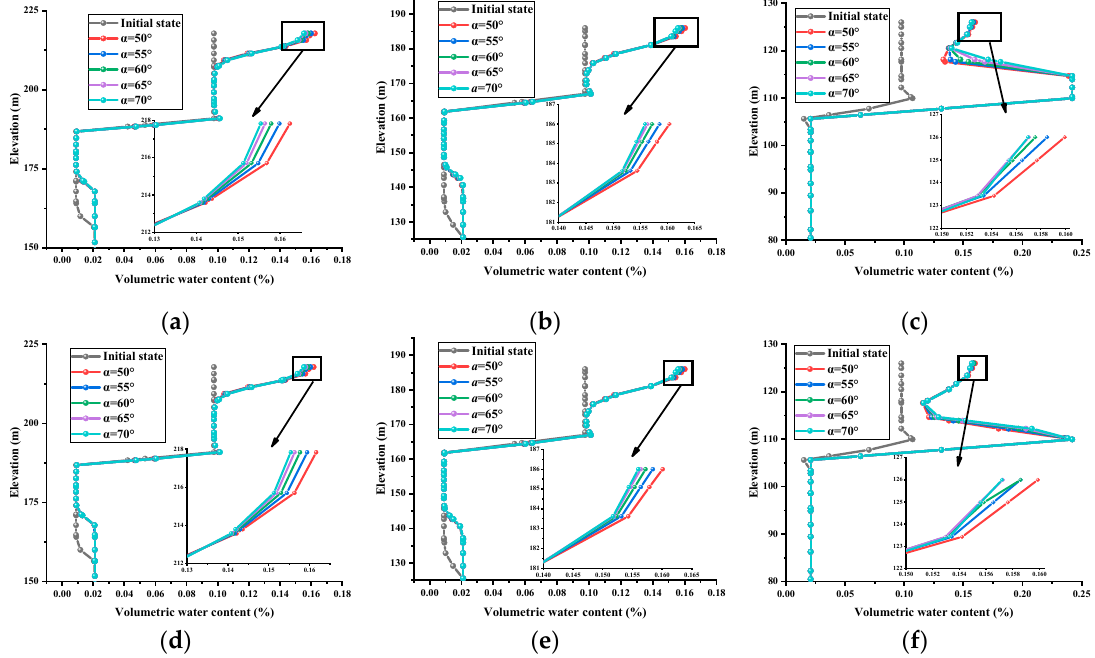
Figure 8. Volumetric water content at different positions on the layered rock slope under different α values with k r = 0.01 and k r = 0.1: ( a ) Top of the slope with k r = 0.01; ( b ) Middle of the slope with k r = 0.01; ( c ) Bottom of the slope with k r = 0.01; ( d ) Top of the slope with k r = 0.1; ( e ) Middle of the slope with k r = 0.1; ( f ) Bottom of the slope with k r = 0.1.